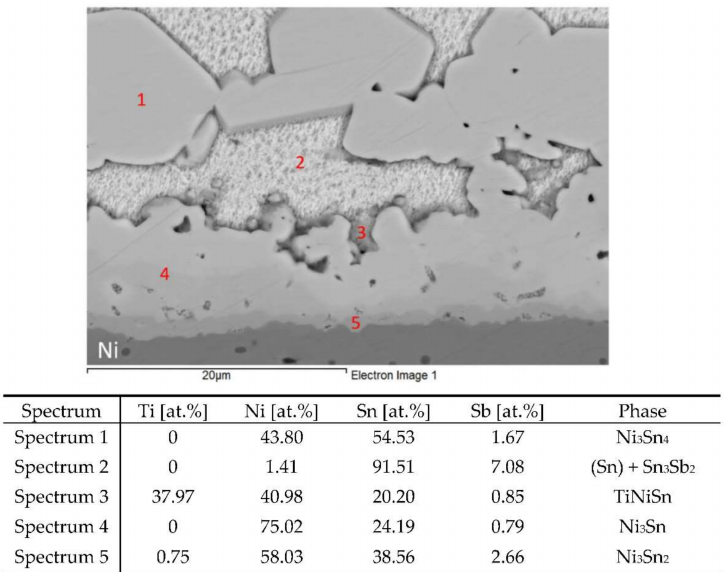
Figure 16. EDX point analysis of boundary in Ni/Sn5Sb3Ti joint.